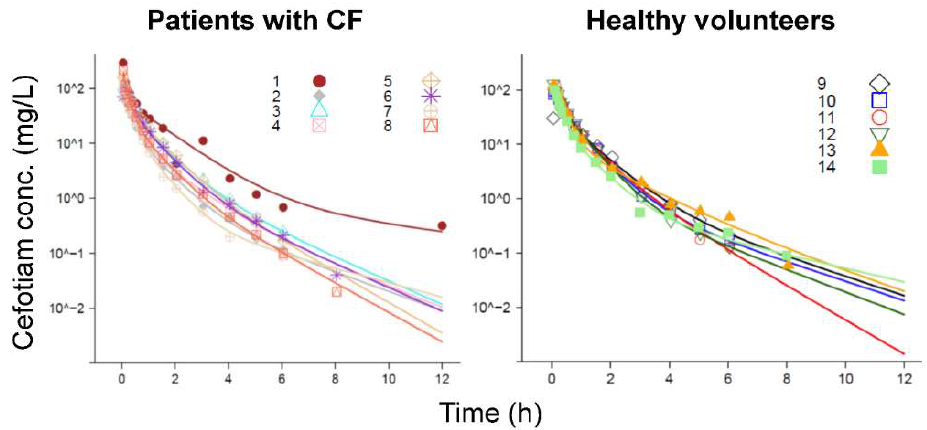
Figure 2. Observed plasma concentrations and individual curve fits (lines) for cefotiam in patients with CF (left) and healthy volunteers (right). The legends show the subject numbers.